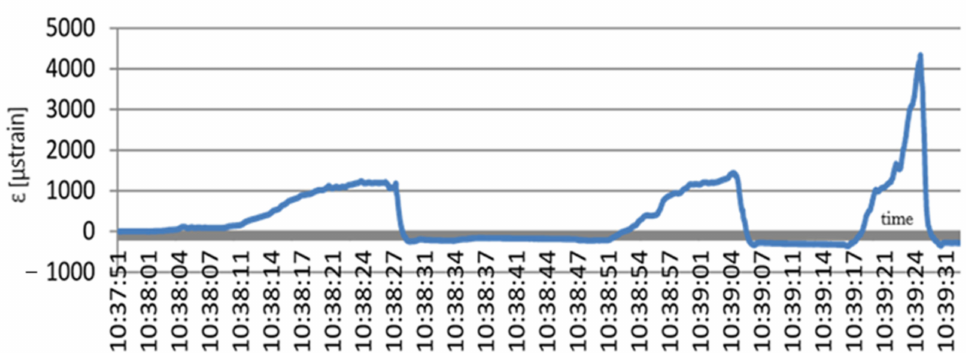
Figure 13. Geogrid strains during the backhoe loader run; x (s); y ( µ strain). The last experiment on the test stand was also carried out using the CASE Super R backhoe loader. This time the excavator supports were spread out and raised the machine. The supports were placed over the sensor to produce the highest loads of the area covered by the FBG monitoring and obtain the highest strains of the geogrid. The strains arising when the construction machine was placed on the geogrid are presented in Figure 14.